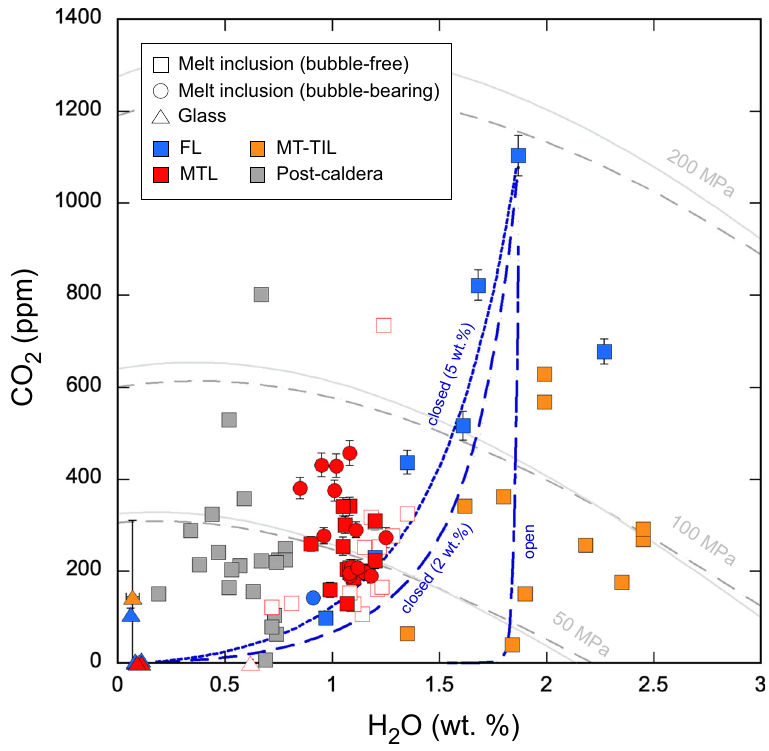
Fig. 5 PEC-corrected H 2 O and CO 2 contents of MI and glass in samples of the FL and MTL eruptions. Bubble-bearing MI are represented by circles and bubble-free MI are represented by squares. Error bars represent the analytical uncertainty (2 σ ) for samples from this study. Grey lines show H 2 O-CO 2 isobars modelled using MagmaSat 41 at 50 MPa, 100 MPa and 200 MPa. The dark grey dashed lines show the isobars produced using the average MI composition of the FL eruption with temperature fi xed at 1060 °C. The light grey lines show the isobars produced using the average MI composition of the MTL eruption 16 , with temperature fi xed at 1100 °C. Closed and open system degassing trends modelled using MagmaSat 41 are shown by the dashed blue lines, all modelled using a fi xed temperature of 1060 °C. Closed system degassing trends are modelled in the presence of a range of exsolved volatile gas contents, expressed in wt. %. Literature data on the MT-TIL and MTL Plinian eruptions and from samples of more recent post-caldera activity 23 are also presented. The standard deviation of glass measurements for samples from Hlinka et al. 23 are indicated by the black lines (1